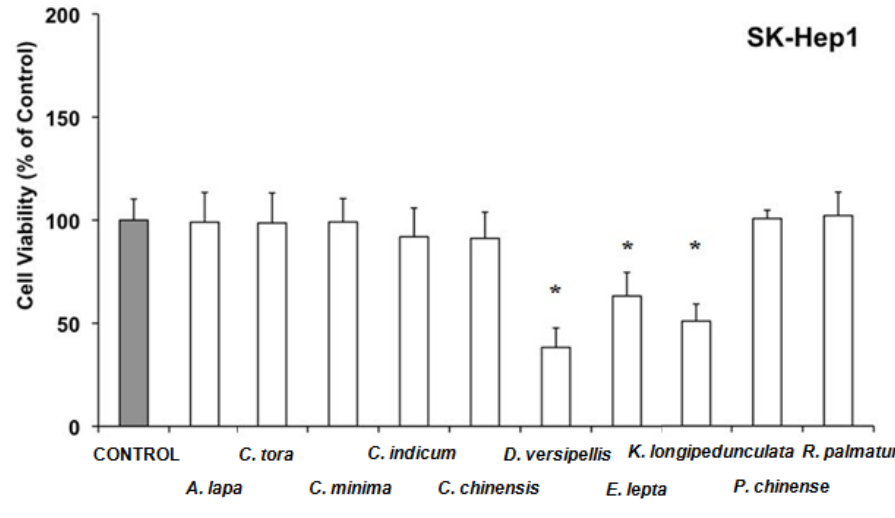
Figure 3. Acute cell toxicity as determined by MTT assay in human hepatoma SK-Hep1 cells. Values are means ± SD of four experiments carried out in triplicate. *, p < 0.05 as compared with Control by the Bonferroni method of multiple range testing.